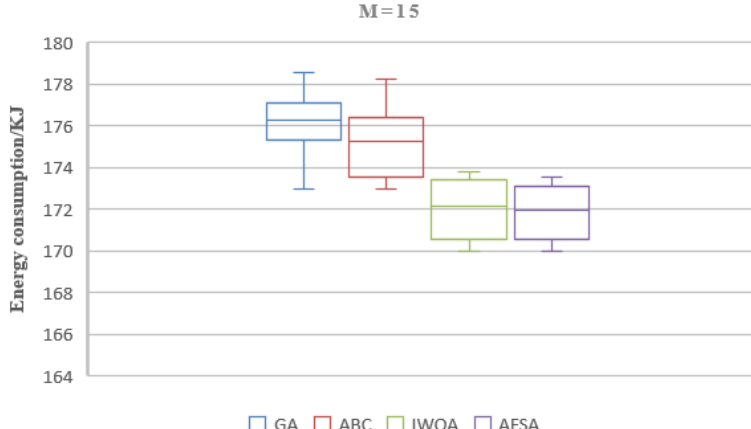
Figure 10. Box plot of run results when the population is 15.